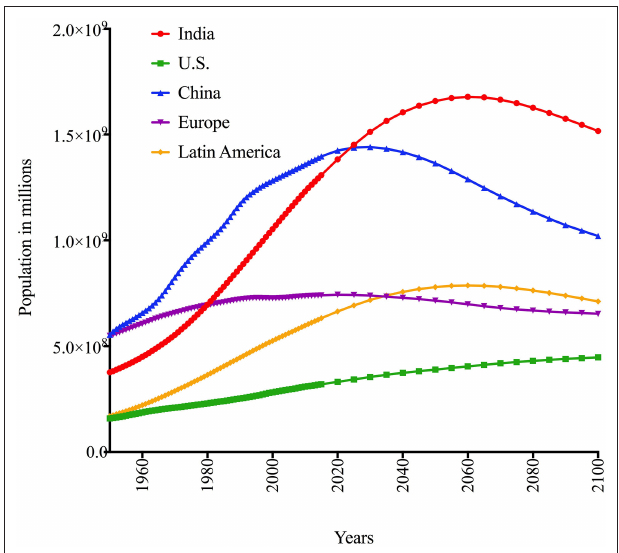
FIGURE 2 | Population Trends: India and the World. Data Source: Department of Economic and Social Affairs, United Nations ( United Nations, 2017).